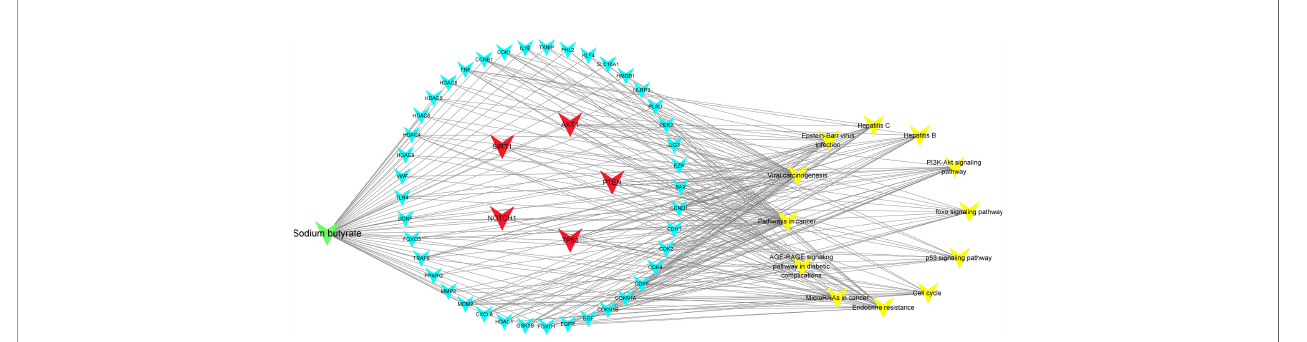
FIGURE 11 | Compound-targets-pathways map was constructed using Cytoscape 3.8.2 software. The compound (sodium butyrate) was green node, targets were blue and red nodes, and pathways were showed by yellow nodes, respectively. The red represents the 5 core target genes. The edges represent the interactions among